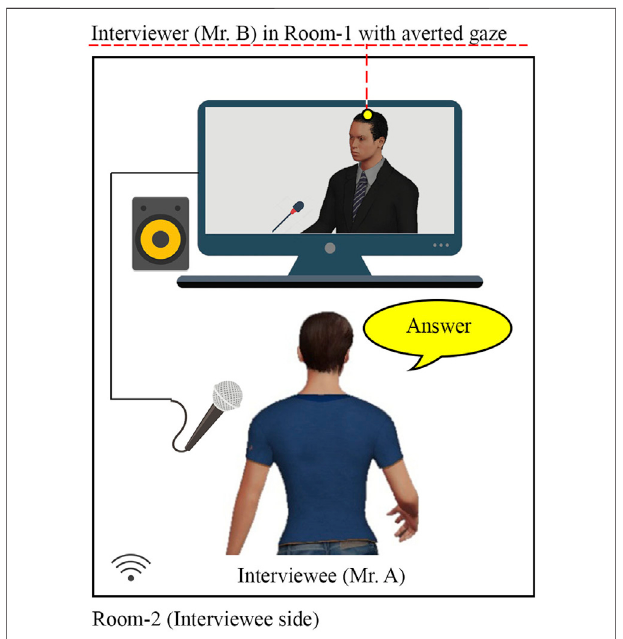
FIGURE 7 | Human condition of Experiment- Ⅱ , (with interviewer ’ s gaze averted from the interviewee).